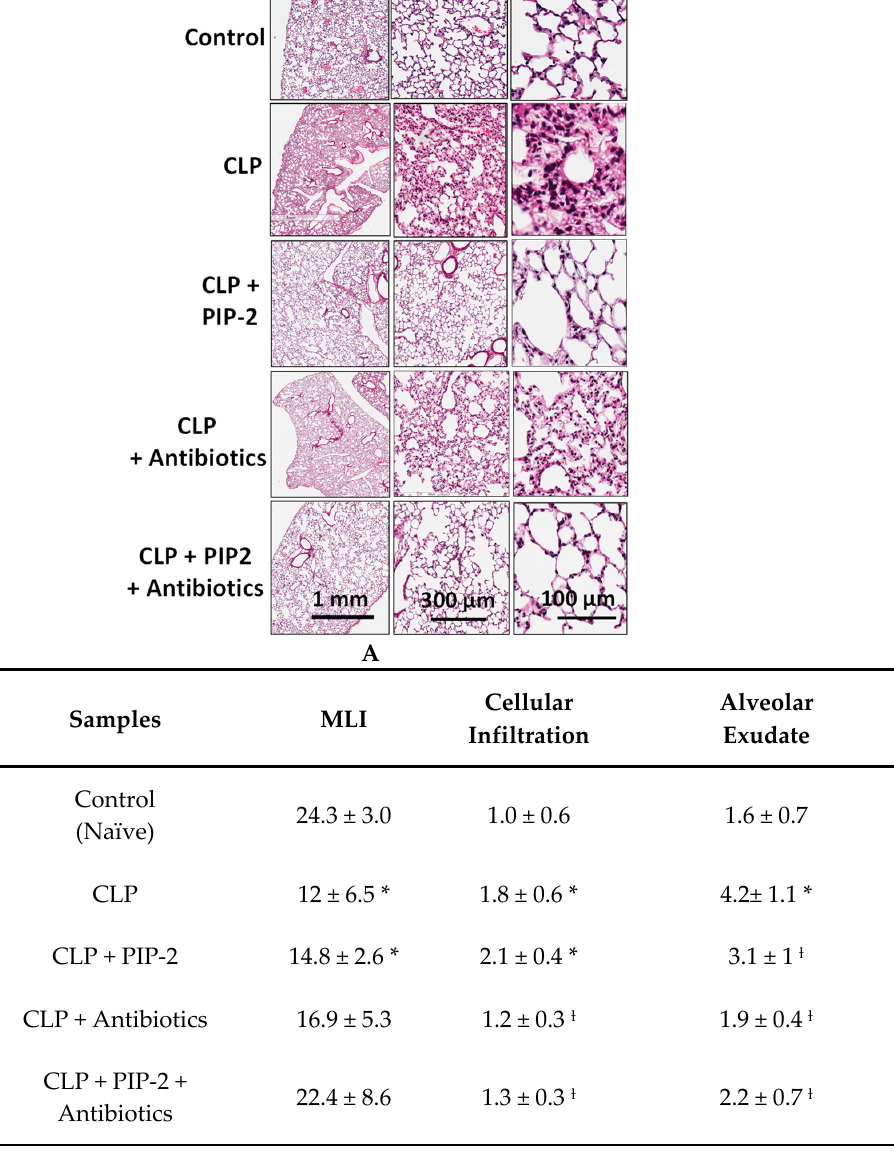
Figure 1. Lung histology with CLP. Mice were treated with antibiotics and/or low dose PIP-2 (2 ug/g) at 6 h after CLP surgery and sacrificed at 24 h. ( A) . Hematoxylin and eosin (H&E) stained lung sections of mice from each group. Representative images shown are at 1 × , 5 × and 40 × magnification. ( B ). Average injury scores for the different groups. Results are the mean ± SD for n = 3 independent experiments (mice) for each group. * p < 0.01 as compared to control; + p < 0.05 as compared to CLP.